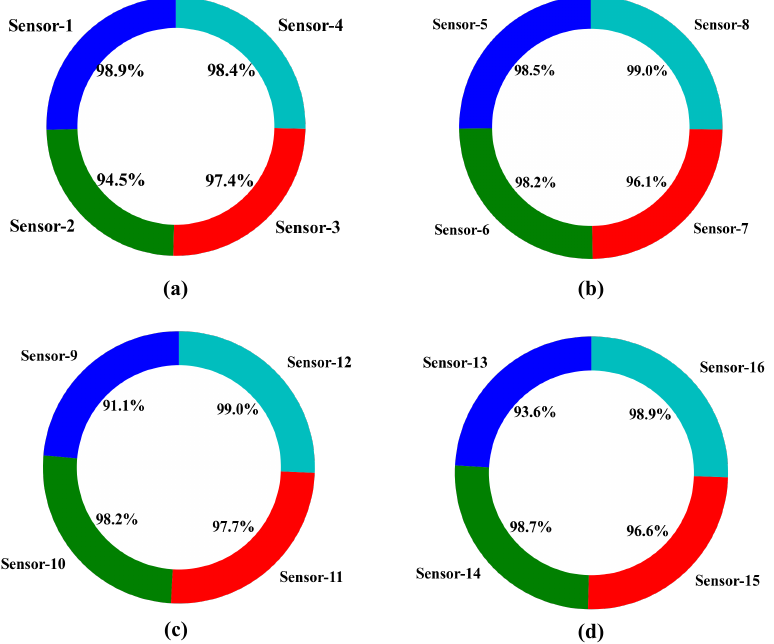
Figure 9. Best sensor selection accuracy: ( a ) Sensor selection accuracy for Area 1; ( b ) Sensor selection accuracy for Area 2; ( c ) Sensor selection accuracy for Area 3; ( d ) Sensor selection accuracy for Area 4.